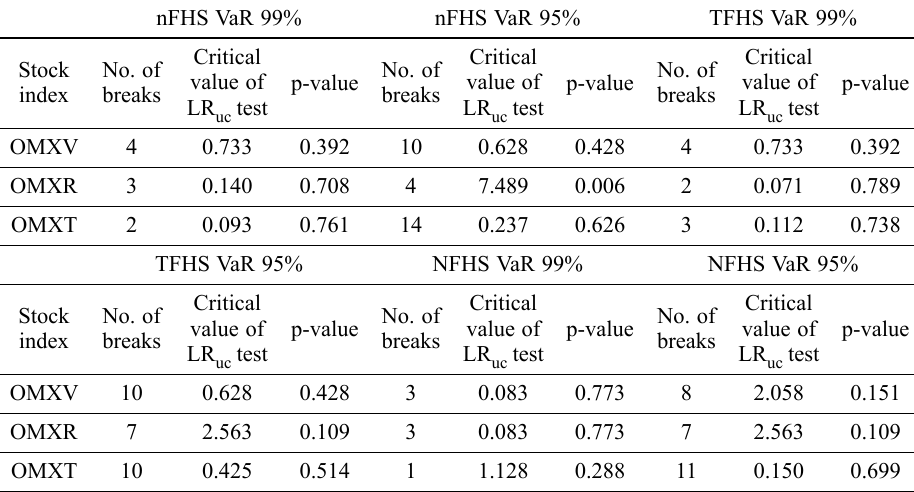
Table 3. Results of Kupiec’s unconditional coverage